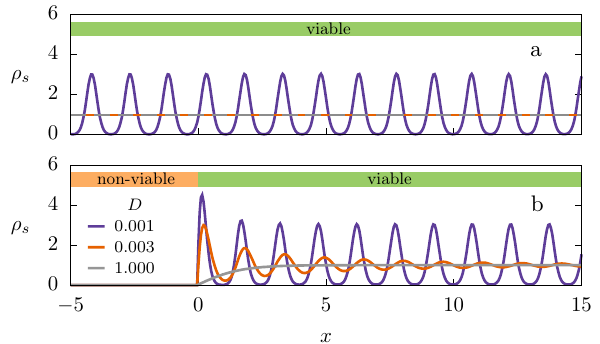
Figure 1. Population distribution in a medium which is ( a ) homogeneously viable, ( b ) heterogeneous, with viable and non-viable regions. Depending on the values of the parameters in Eq. (3), spatial patterns can develop around the uniform steady state in ( a ), and they are preserved in the viable region of the corresponding case in ( b ). But even when the steady state is uniform in ( a ), decaying oscillations can emerge in ( b ). Parameters are 1 , values of D are given in the legend, and for kernel γ 2 . 0.5 and ℓ a b q defined in Eq. (4), we fix q = − = = = For panel ( b ), A in Eq. (9) is A → ∞